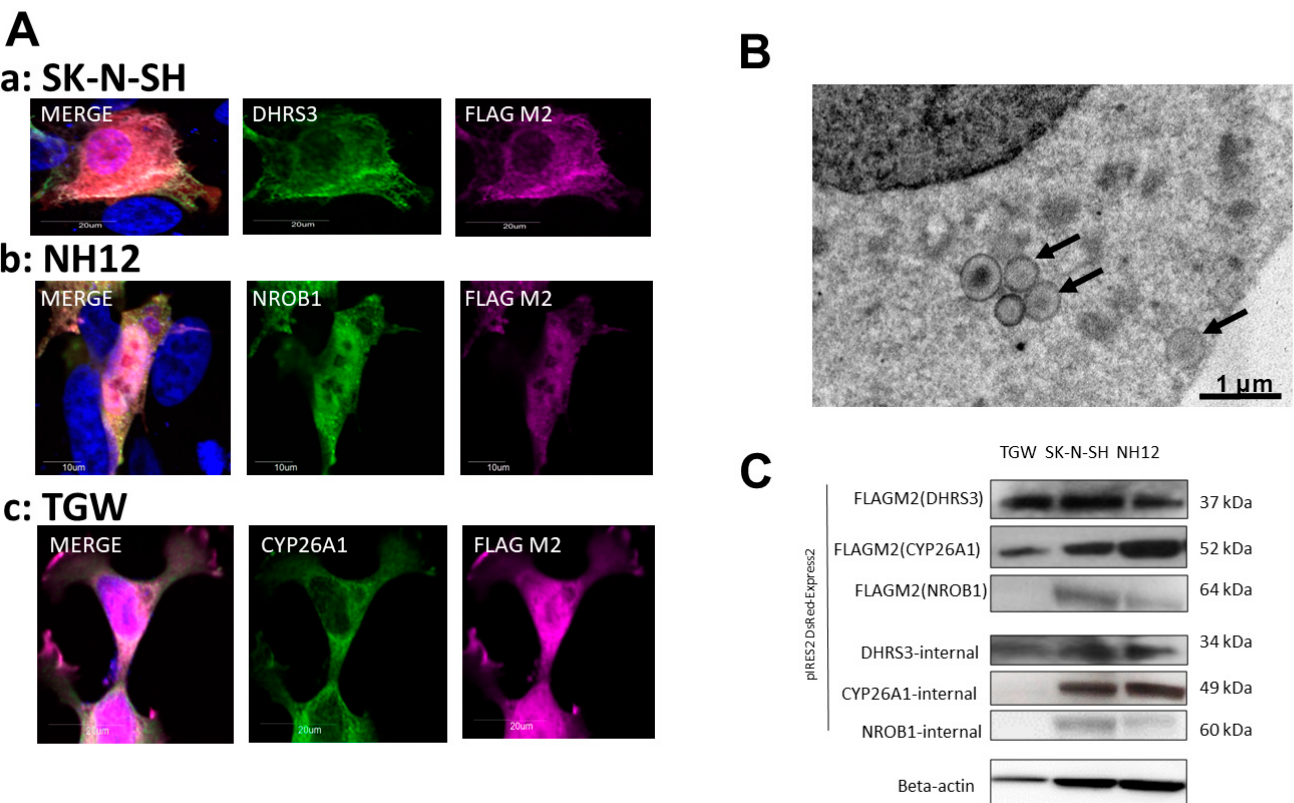
Figure 1. Transfection efficiency in SK-N-SH, NH12, and TGW neuroblastoma cell lines. Representa- tive images of transfected, undifferentiated neuroblastoma cell lines. ( A ) Stable expression levels of transfected gene products were assessed with fluorescent immunostaining in transfected cell lines (a–c). Expression of exogenous proteins was detected with FLAG M2 antibodies and their respec- tive endogenous antibodies. In established cell lines, DHRS3 was expressed mainly in the plasma membrane and endoplasmic reticulum (a,b). The merged photos include nuclear staining by DAPI. ( B ) DHRS3-transfected strains were lipid-stained using Lipid Tox and visualized by transmission electron microscopy, and we found an accumulation of DHRS3 in small vesicles (arrows). These vesicles were observed shortly after transfection in NH12 and SK-N-SH cells but were absent in TGWs. In addition, CYP26A1 was also expressed in both the nucleus and the endoplasmic reticulum, and NROB1 was expressed in the nucleus (b). ( C ) The presence of the exogenous proteins was confirmed by their expected molecular weights by Western blotting.